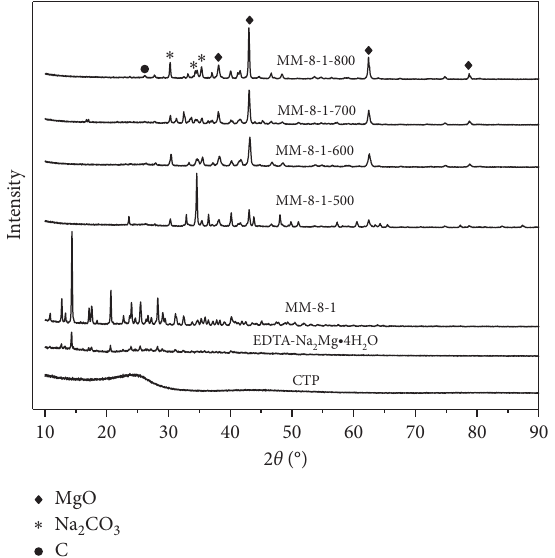
Figure 3: XRD patterns of raw materials and the cokes of MM-8-1 heat-treated at different temperatures.